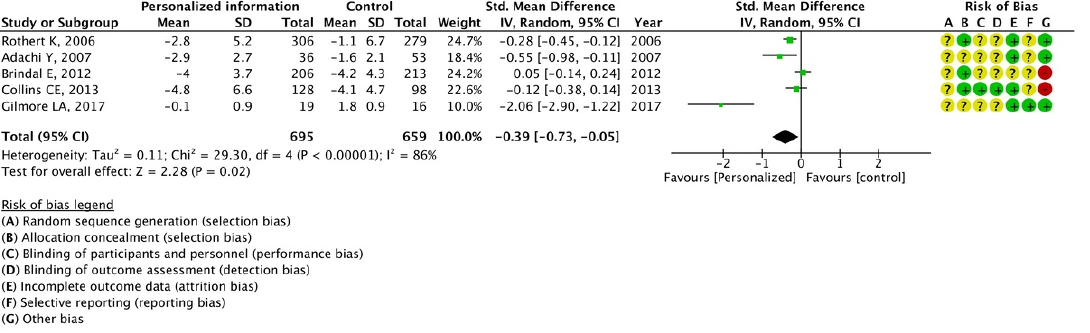
Figure 6. Meta-analysis for mean weight change with or without e-counseling using 4 articles [14,19,43,57]. The forest plot shows standardized mean differences (SMD) for each article with 95% confidence intervals (CI). The diamond at the bottom of the graph means the meta-analyzed measure of effect and the lateral points of which indicate CIs for this estimate. A positive value reflects web-based interventions with e-counseling are more effective for weight loss than web- based interventions without e-counseling. The area of each green square is proportional to the study's weight in the meta-analysis.